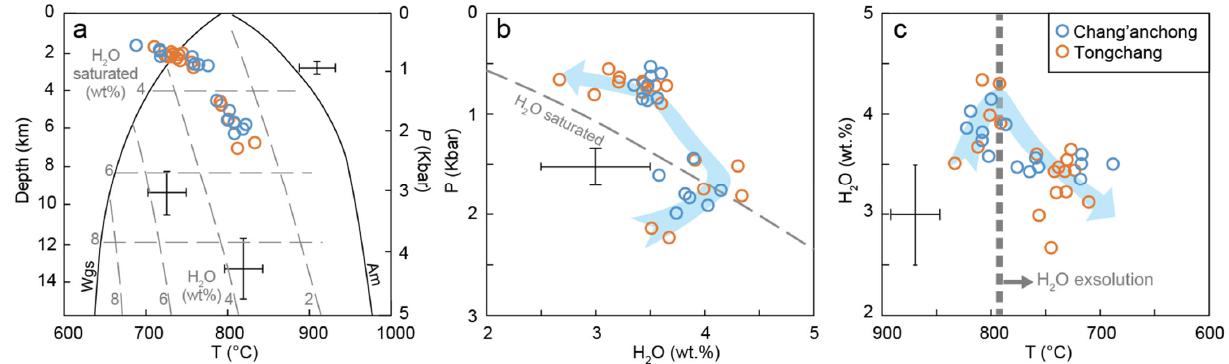
Figure 8. ( a ) The calculated P–T conditions for Tongchang and Chang’anchong quartz syenite porphyries. Cross bars indicate the P–T uncertainties [69]. Liquidus for amphibole is delineated with black solid lines, labeled on their unstable side [90]. The wet granite solidus (Wgs) line is delineated with a black solid line [89]. The steep grey dashed lines are undersaturated liquidus (with wt% H 2 O labeled) and the subhorizontal dashed lines are H 2 O solubility limits (also labeled as H 2 O saturated) [88,89]. Am, amphibole; Wgs, wet granite solidus. ( b ) The calculated pressure condition vs. magmatic H 2 O content for Tongchang and Chang’anchong quartz syenite porphyries. Cross bars indicate the P–H 2 O uncertainties [69]. The dashed line shows the H 2 O solubility curves [88]. ( c ) The calculated T–H 2 O conditions for Tongchang and Chang’anchong quartz syenite porphyries. Cross bars indicate the T–H 2 O uncertainties [69]. The thick dashed line represents the H 2 O exsolution process.